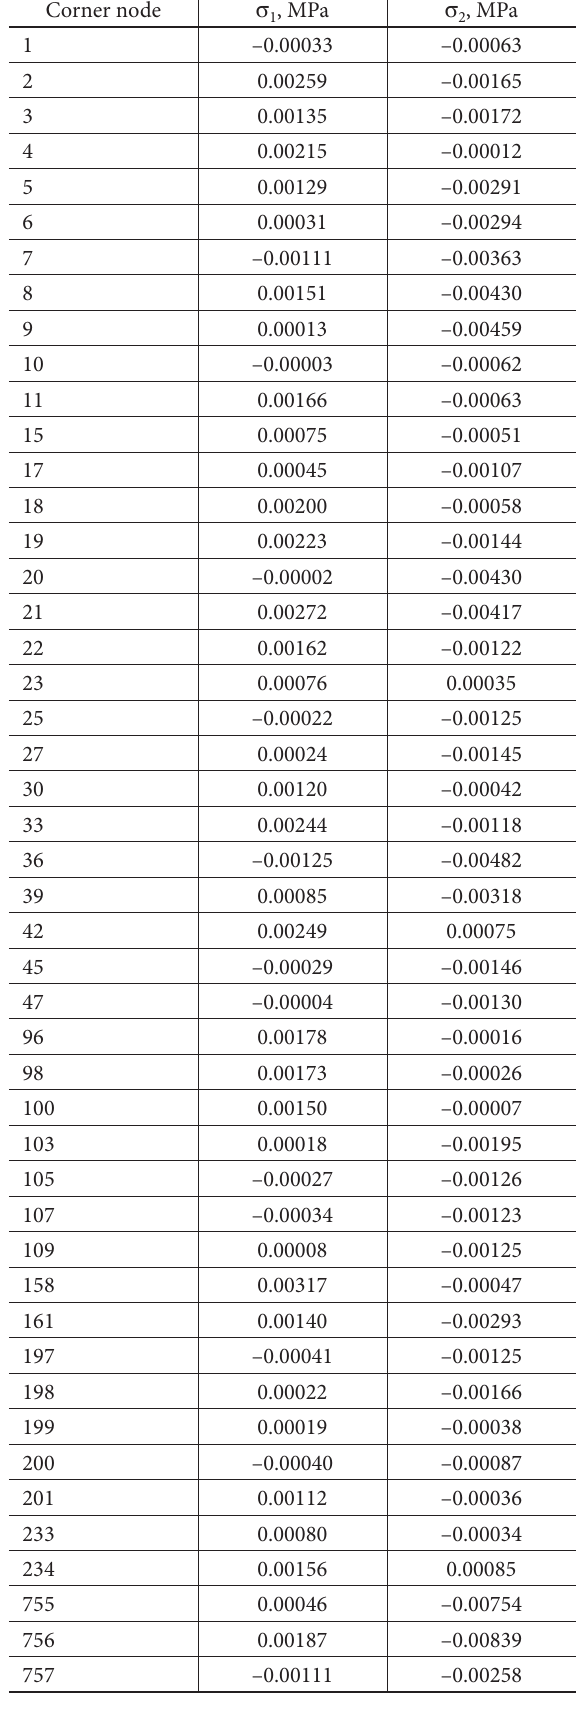
Table 2. Calculated changes in principal